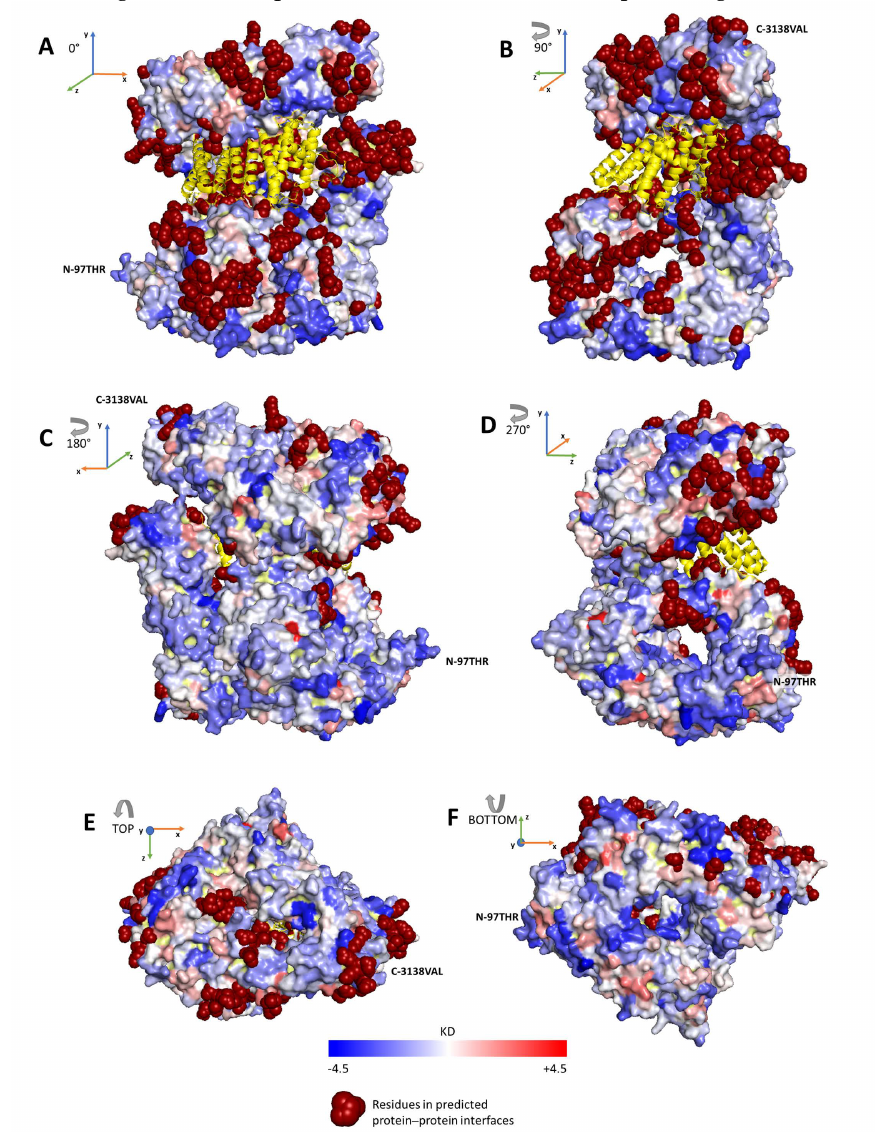
Figure 3. Surface residues labeled as putative interaction sites. The Figure depicts the protein structure of huntingtin in complex with HTT -associated protein 40 (HAP40 , colored in yellow) [19] and captured by six different views: with a clockwise rotation of the protein around the vertical axis with 90-degree steps ( A – D ) and the top and bottom views with respect to the vertical axis ( E , F ). Dark-red spheres represent surface residues labeled as interacting sites by ISPRED4 [21] (see Materials and Methods, Table